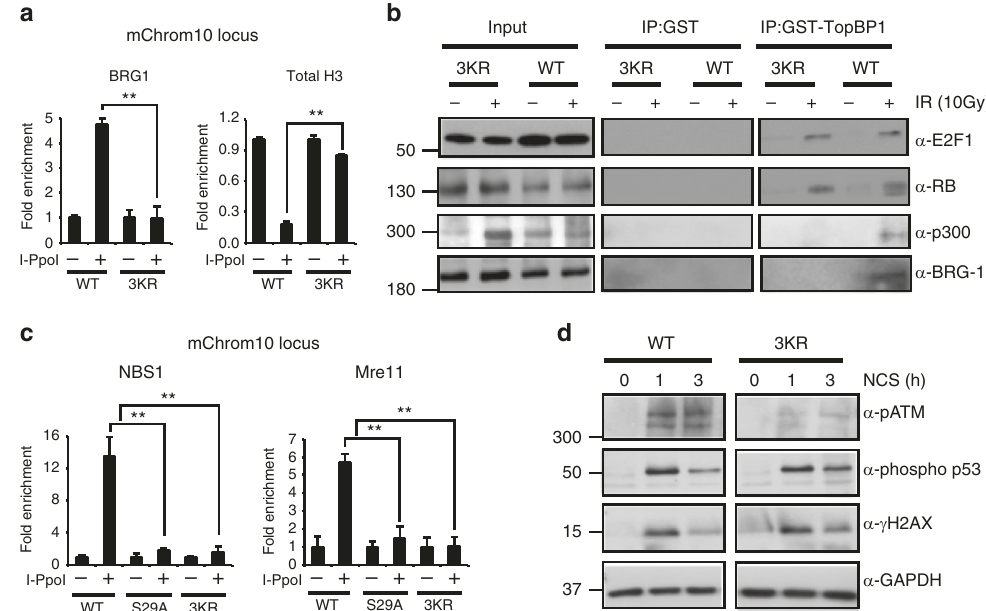
Fig. 6 The E2F1 3KR mutation impairs BRG1 and MRN accumulation at a DSB. a Primary wild-type (WT) and E2f1 3KR/3KR (3KR) MEFs were subjected to the I-PpoI ChIP assay and occupancy of BRG1 and total histone H3 was determined by qPCR at mChrom10 locus. b Puri fi ed GST-TopBP1 (BRCT1-6) or GST control protein was incubated with whole-cell extract from wild-type (WT) or E2f1 3KR/3KR (3KR) MEFs that were either untreated ( − ) or treated ( + ) with IR (10 Gy) and harvested 2 h post-IR. Associated proteins were pulled down using glutathione beads and western blot was performed with the indicated antibodies. c Primary wild-type (WT), E2f1 S29A/S29A (S29A), and E2f1 3KR/3KR (3KR) MEFs were subjected to the I-PpoI ChIP assay and occupancy of NBS1 and Mre11 was determined by qPCR at mChrom10 locus. d Western blot analysis was performed for phospho-ATM (serine 1981), phospho-p53 (serine 15), γ H2AX, and GAPDH using whole-cell extracts from primary wild-type (WT) and E2f1 3KR/3KR (3KR) MEFs, before treatment or 1 h and 3 h post-treatment with 250 ng/ml of NCS. All graphs represent average ± SD of three independent experiments ( n = 3). P values were calculated by unpaired Student ’ s t test. ** P ≤ 0.01 is highly signi fi cant. Source data of b and d are provided as Supplementary Data 5. Raw data of a and c are in Source Data